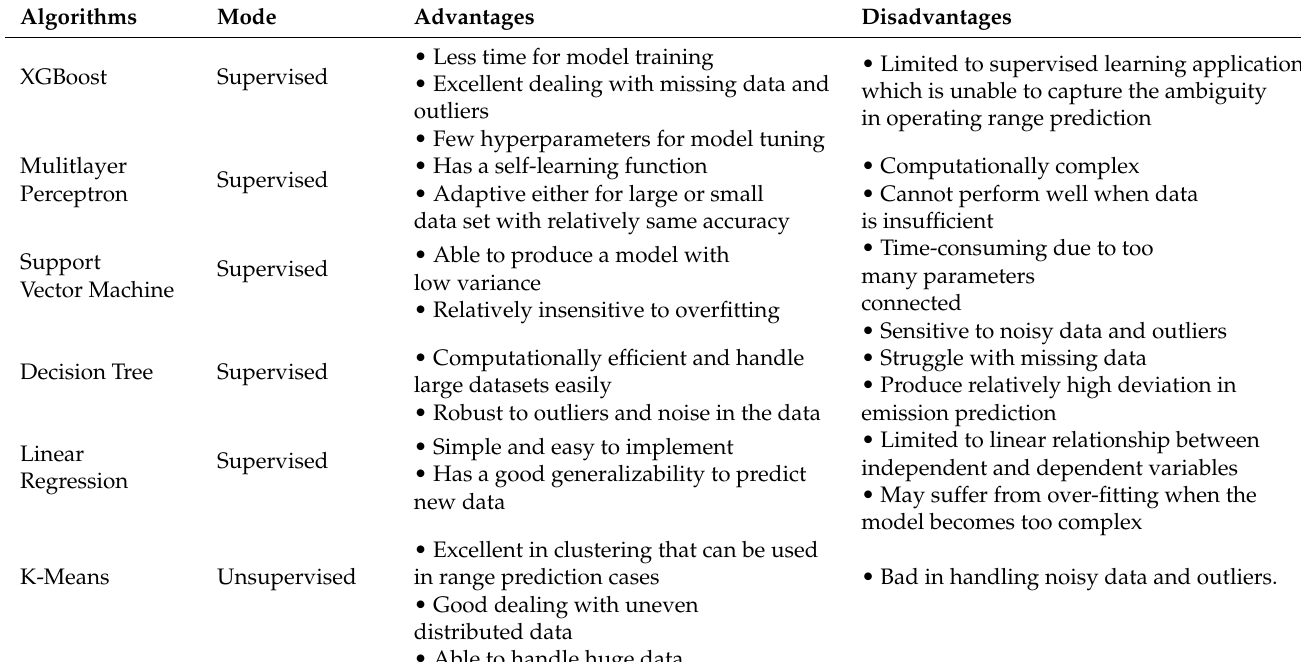
Table 6. Summary of the advantages and disadvantages of all